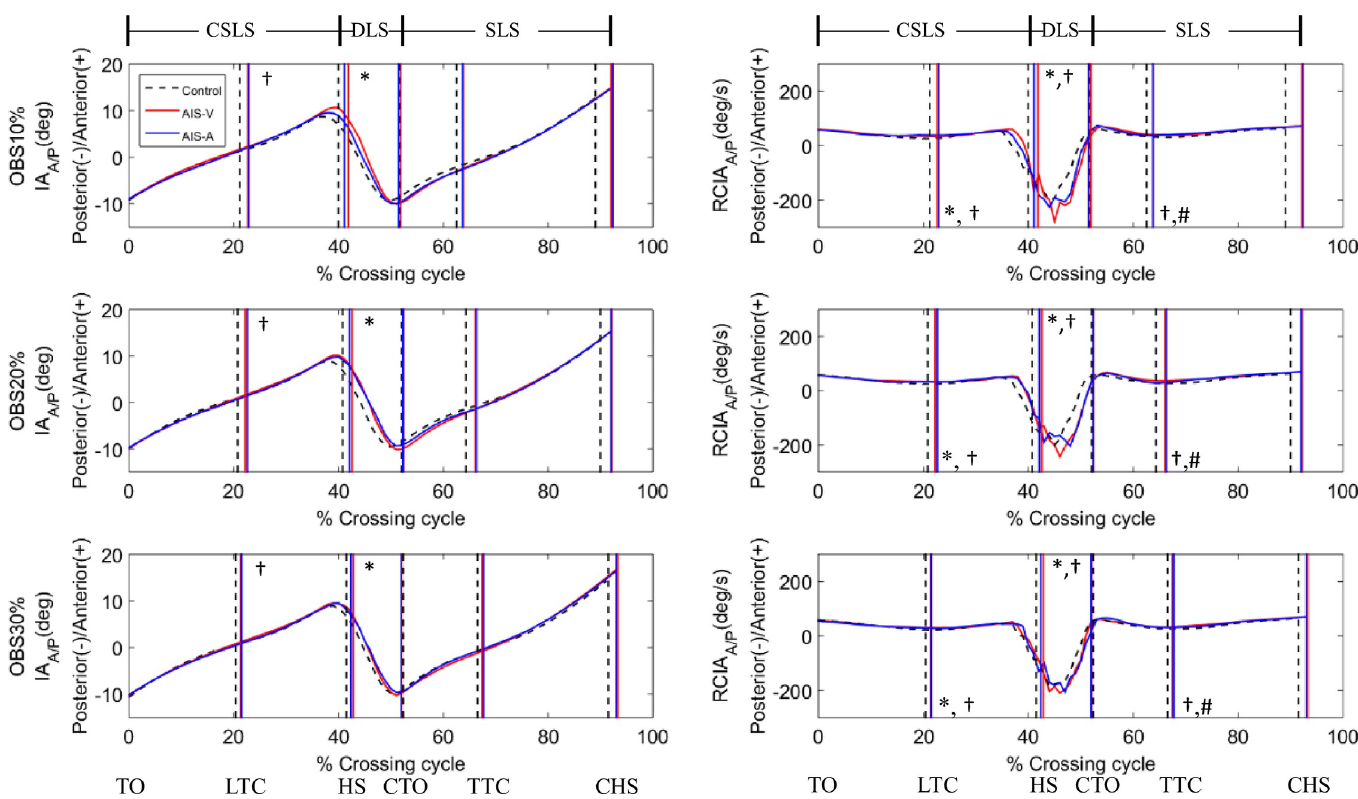
Fig 1. Ensemble-averaged curves of (A) COM-COP inclination angle (IA), and (B) rate of change of IA (RCIA) in the sagittal plane over the crossing cycle when crossing obstacles of heights of 10%, 20% and 30% the leg length (LL) for convex side, concave side and controls, drawn with data points at an interval of 1% crossing cycle. The anterior/posterior (A/P) position of the COM and COP were described parallel to the direction of progression, a zero value being the position of toe-off and a positive value being anterior to that position. (TO: toe-off of the leading limb; LTC: leading toe above the obstacle; HS: heel-strike of the leading limb; CTO: toe-off of the contralateral limb; TTC: trailing toe above the obstacle; CHS: heel-strike of the contralateral limb; SLS: single-limb support of the leading limb; CSLS: contralateral single- limb support; DLS: double-limb support; � : AIS-A significantly different from Control; †: AIS-V significantly different from Control; #: AIS-A significantly different from